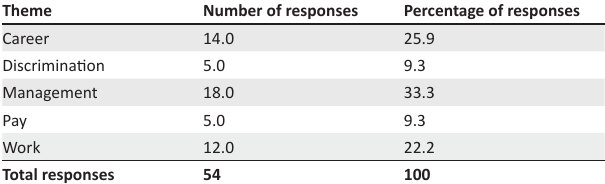
TABLE 14: Downtrodden cluster of individuals.